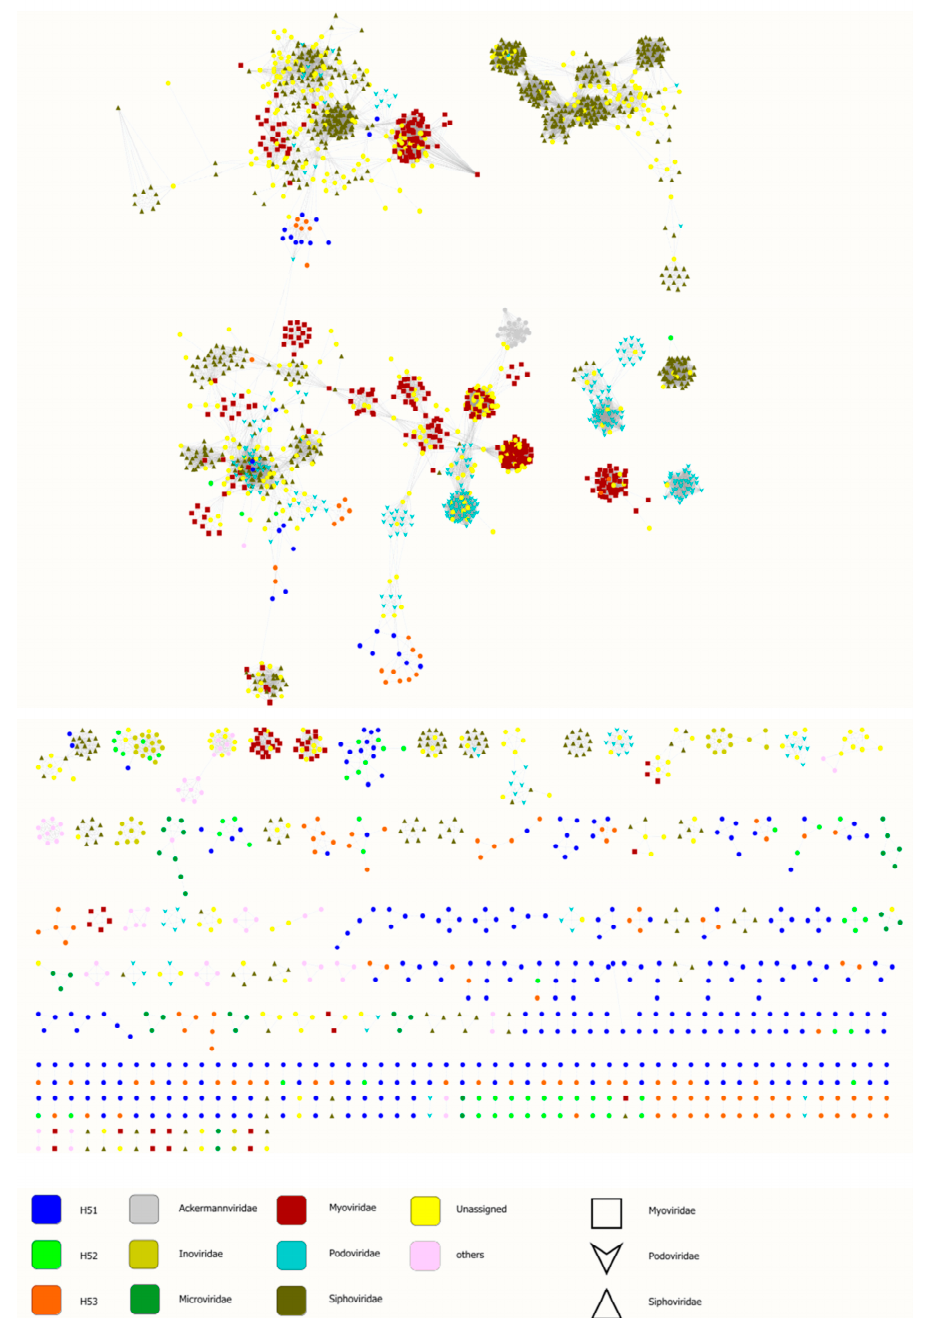
Figure 6. A network analysis of shared predicted protein content between viral RefSeq database and Hainich viral populations. Nodes (circles) indicate contigs and shared edges (lines) indicate shared protein content. Data were analysed using vConTACT2 [61,62] and displayed with cytoscape [64].